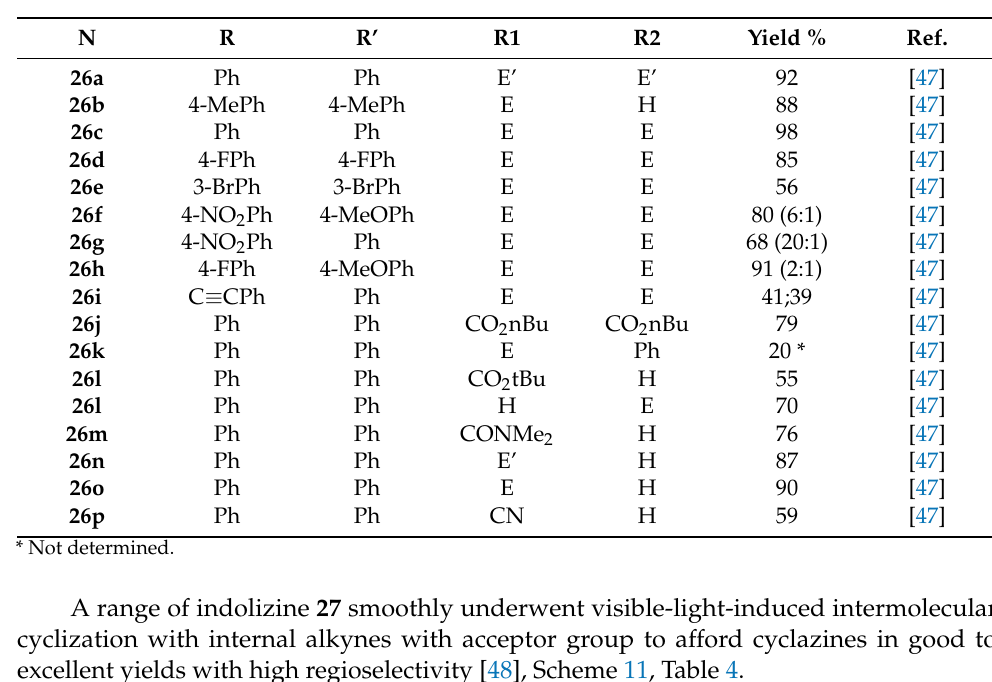
A range of indolizine 27 smoothly underwent visible-light-induced intermolecular cyclization with internal alkynes with acceptor group to afford cyclazines in good to ex- cellent yields with high regioselectivity [48], Scheme 11, Table 4.